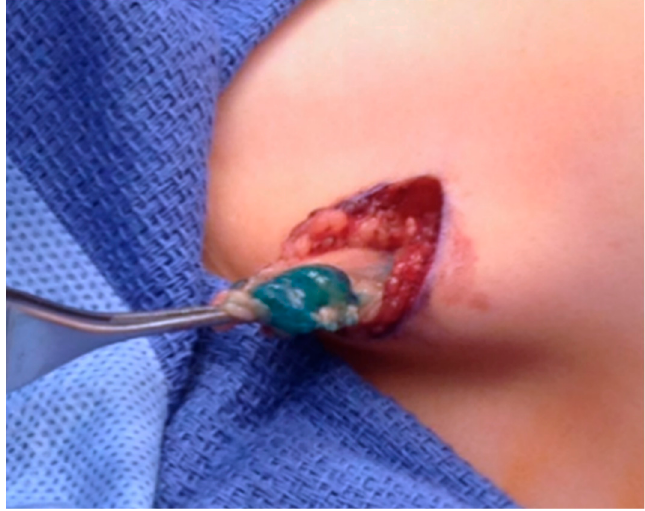
Figure 5. Axillary Sentinel Lymph Node Biopsy for trunk RMS. Blue dye can be appreciated in the sample.